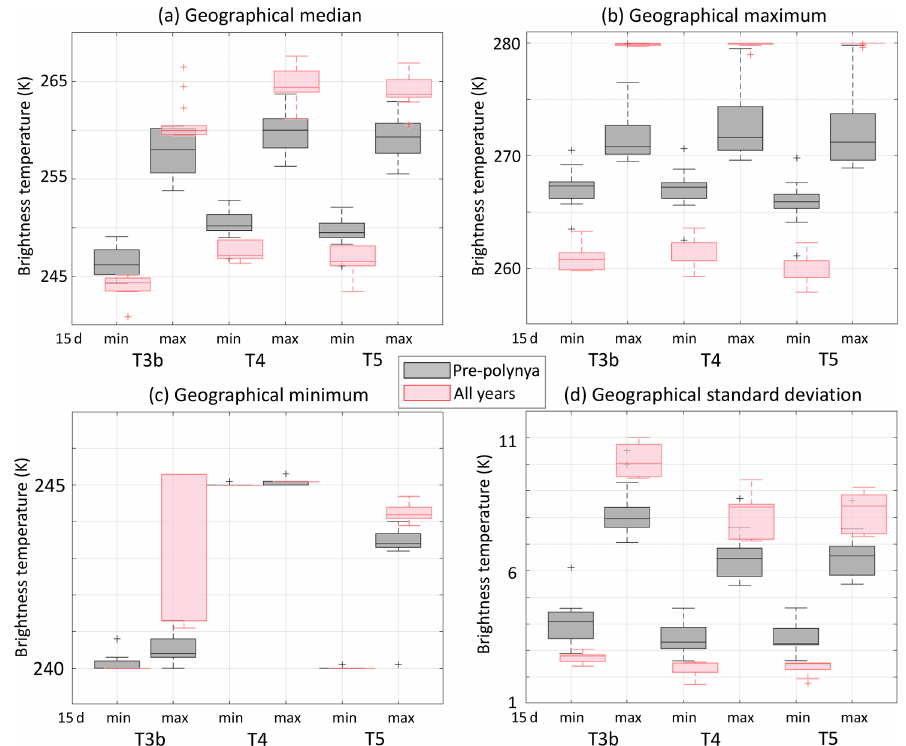
Figure 4. Over the polynya-prone region, for all bands, whisker plot of the minimum ( x axis) and maximum ( y axis) infrared brightness temperature over the time period from 15d before the polynya opens until the day of opening of the geographical median (a) , maximum (b) , minimum (c) , and standard deviation (d) . Grey colours show the values of the years where a polynya opens; pink shows the values for the same dates in all